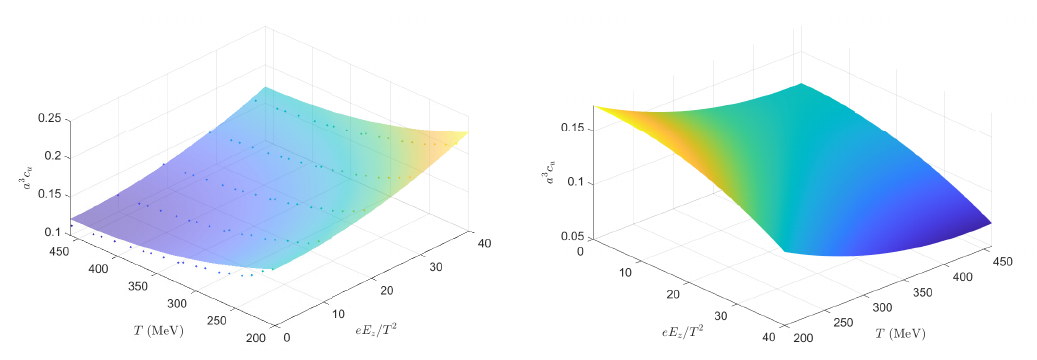
and c T,E z fitted using eq. (3.6) (the left panel) and analytical extension of fitted Figure 10 . c T,E z u u (the right c T,E z u